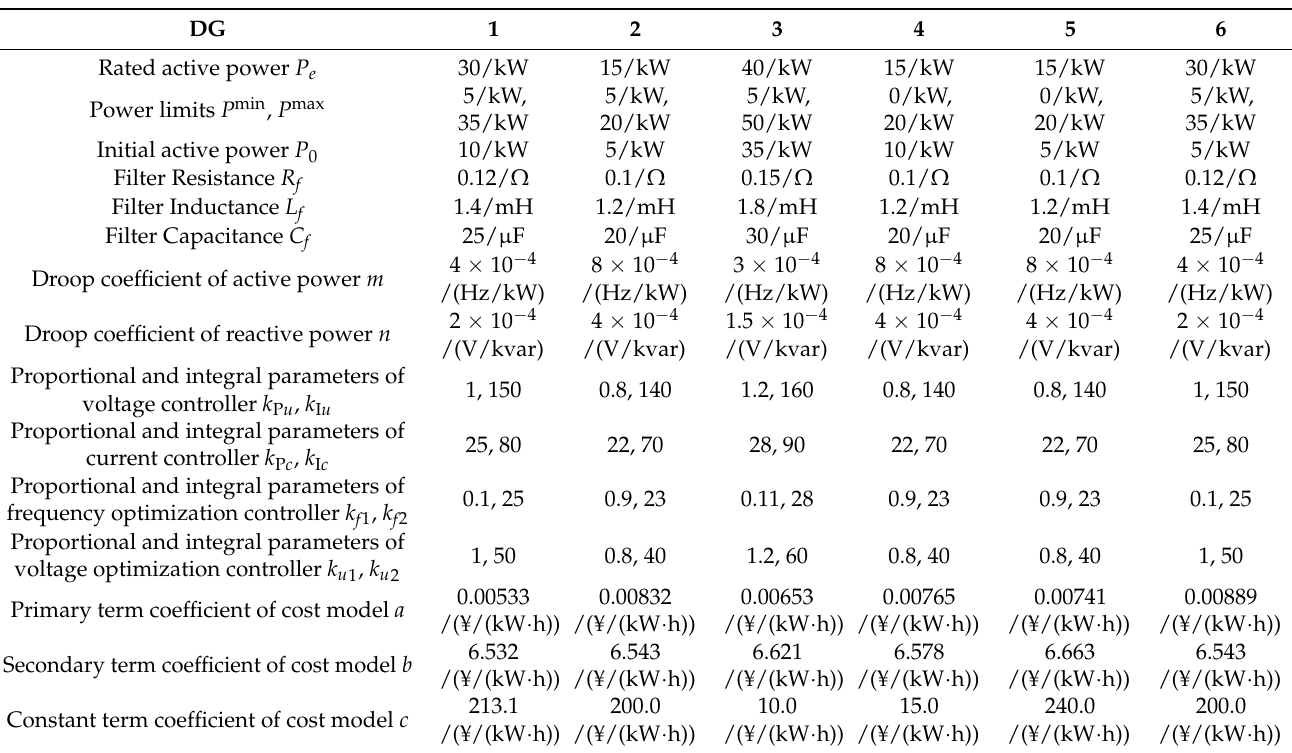
Table 1. Rated active power, power limits, initial active power, filter parameters, control parameters, and cost model parameters of each DG.